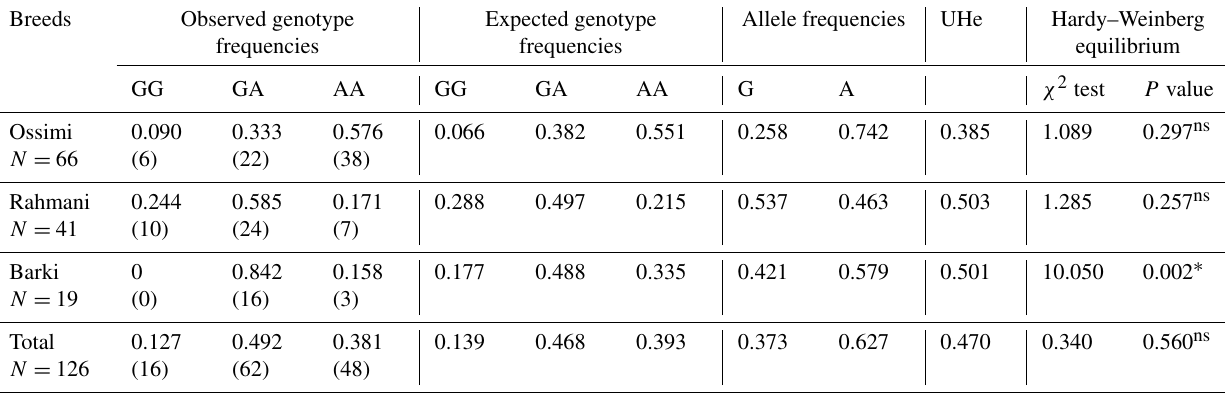
Table 2. Genotypes and allele frequencies of the AA-NAT SNP in Egyptian sheep breeds. Where N is the total number of animals in each breed; UHe is the unbiased expected heterozygosity; number in parentheses is the no. of genotype observed; ns represents non-significant. Breeds Observed genotype Expected genotype frequencies frequencies